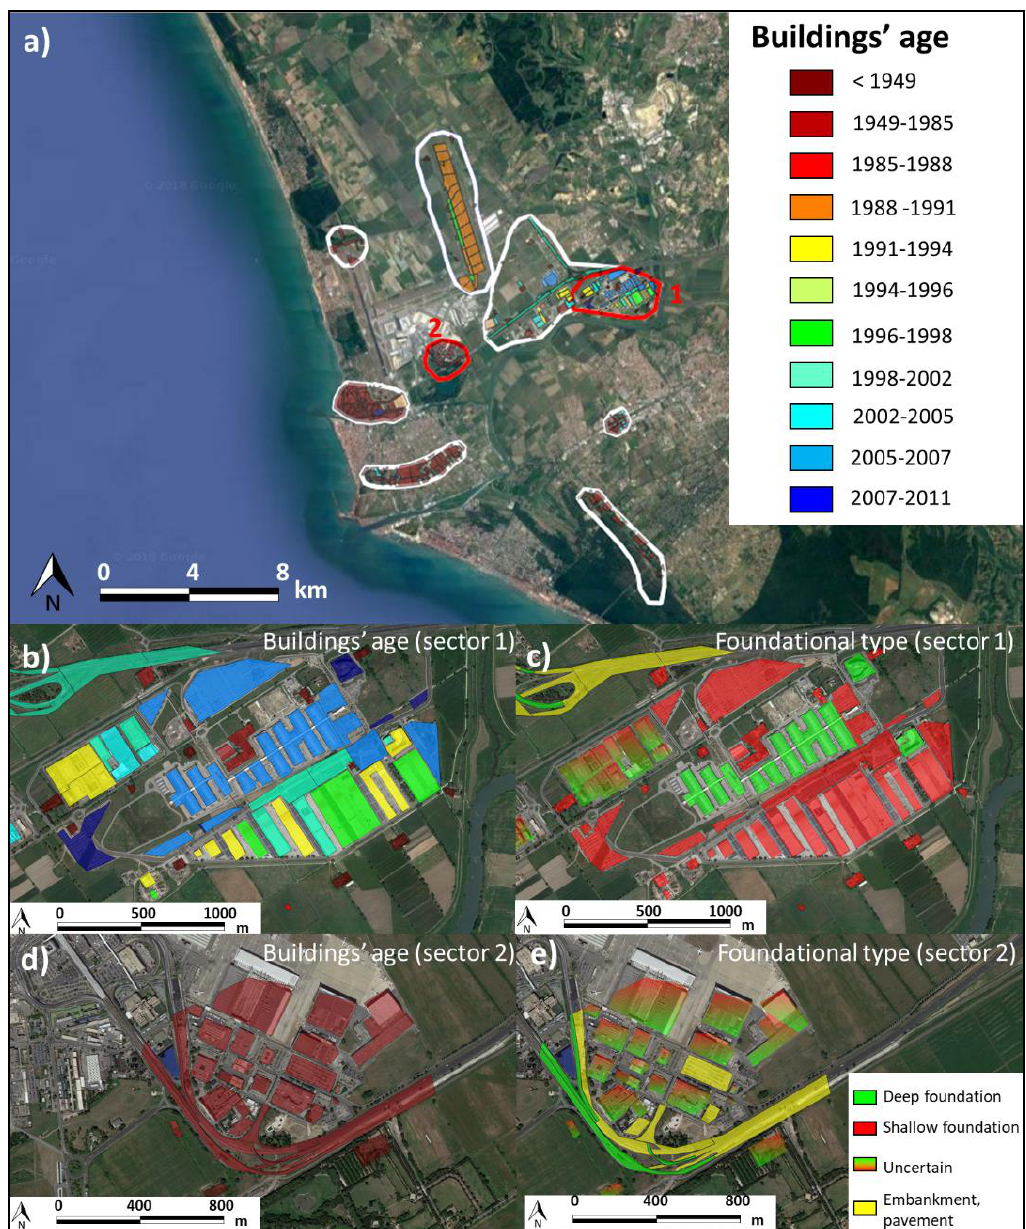
Figure 10 . Classification of the building ages in the eight investigated regions ( a ); and zoom on sector 1 ( b ); and sector 2 ( c ) discussed in detail in this paper. For these sectors, the foundation type of the buildings is also reported ( d , e ).